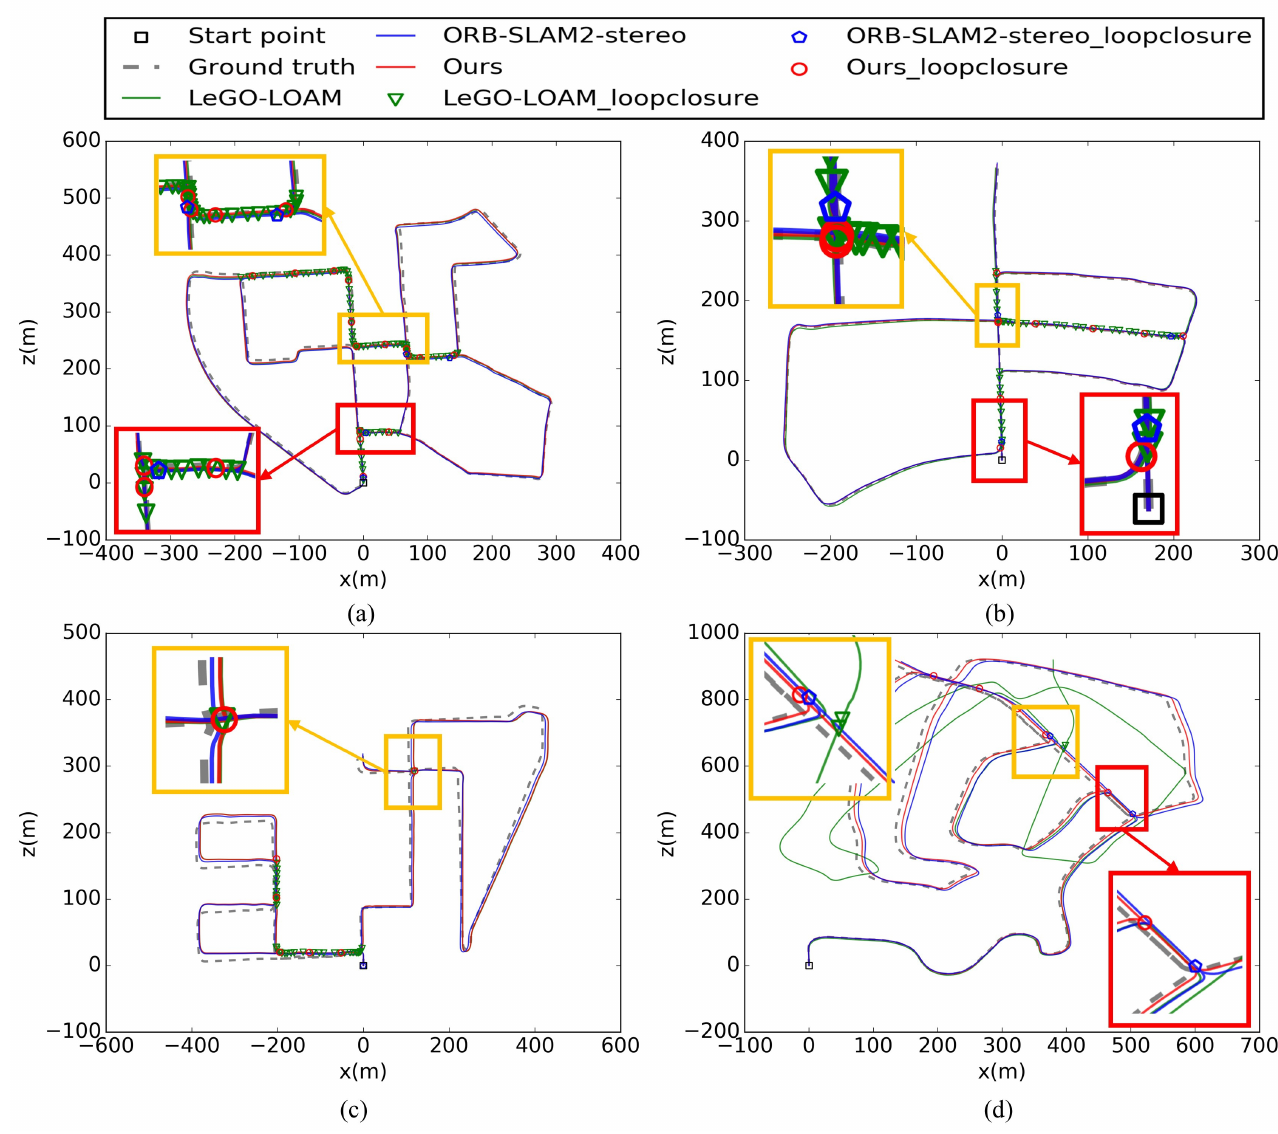
Figure 23. The loop closure detection results of partial KITTI sequeces, where ( a ) is sequence 00, ( b ) is sequence 05, ( c ) is sequence 08 and ( d ) is sequence 02. The trajectory of Ground Truth is plot in dash gray line, the blue line and red line represent stereo ORB-SLAM2 and ours trajectories respectively. The loop closures detected by our approach are drawn with red circle, and the detected loop closures of LeGO-LOAM and stereo ORB-SLAM2 are drawn with triangle and pentagon